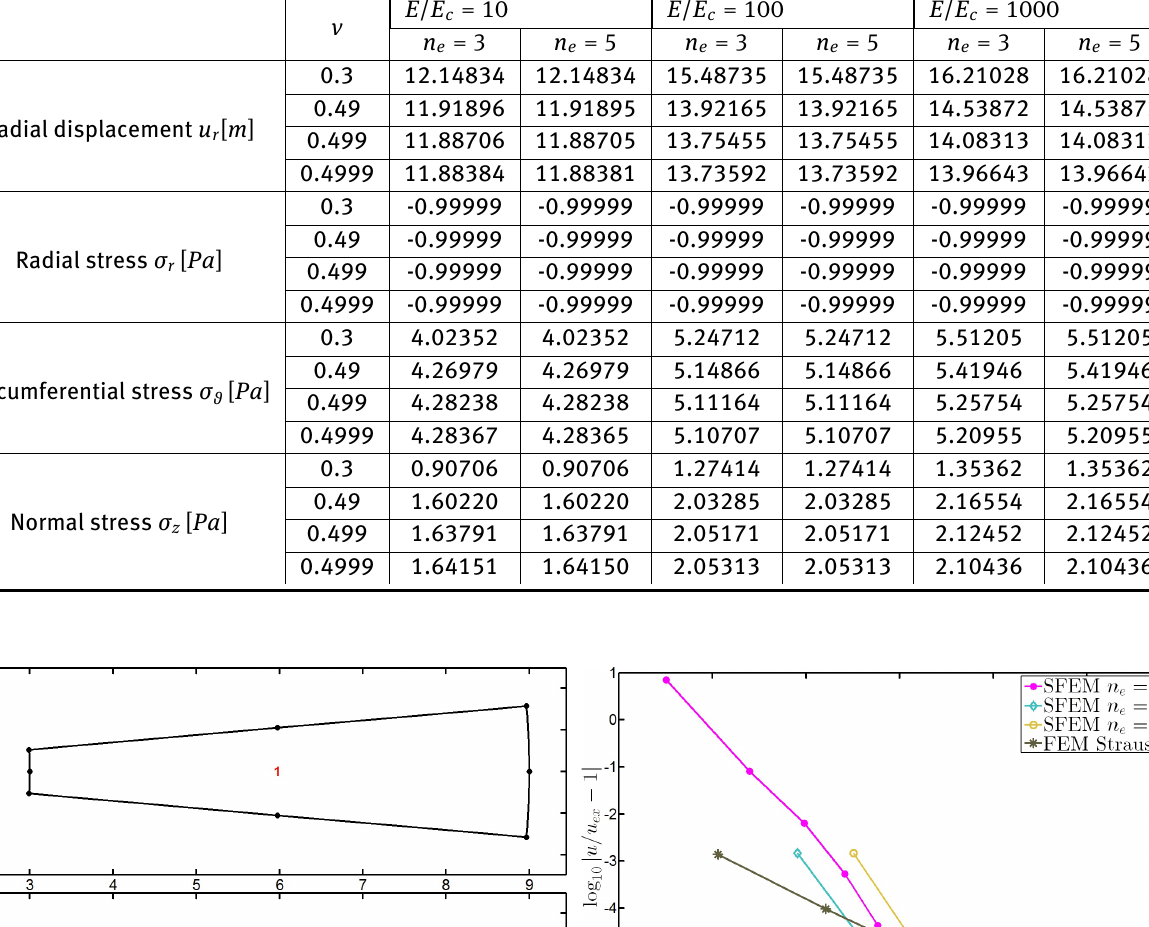
Figure 9: Convergence and stability curves for an isotropic thick- walled cylinder using different